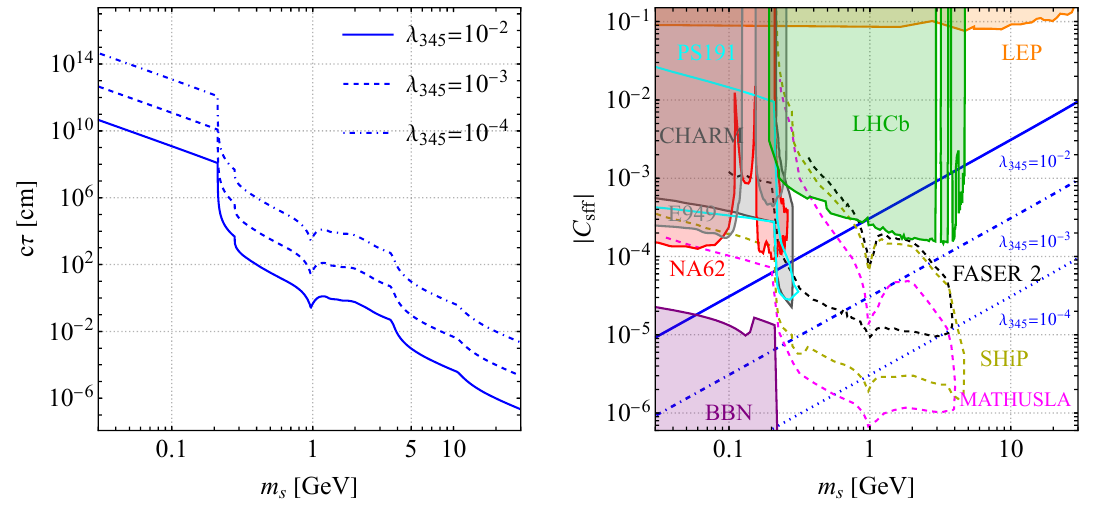
Figure 2 . Left: proper lifetime contour along 10 − 7 ≤ r ≤ 10 − 1 of the light CP-even Higgs s for various values of λ . The decay widths into hadronic final states are taken from [37]. Right: 345 bounds on the light CP-even Higgs in the | C - m plane. The blue lines show the same contours sff | h as in the left panel, where we vary 10 − 7 ≤ r ≤ 10 − 1 and fix λ and µ 2 such that we reproduce m h = 125 GeV and v = 246 GeV. For an overview of the bounds and their origin see the main text.